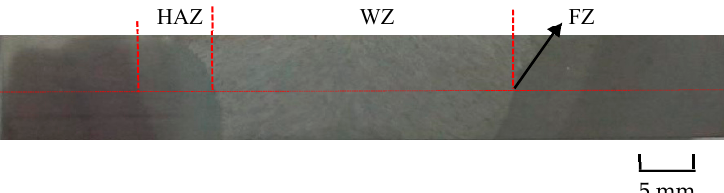
Figure 14. Welded joint macrostructure.